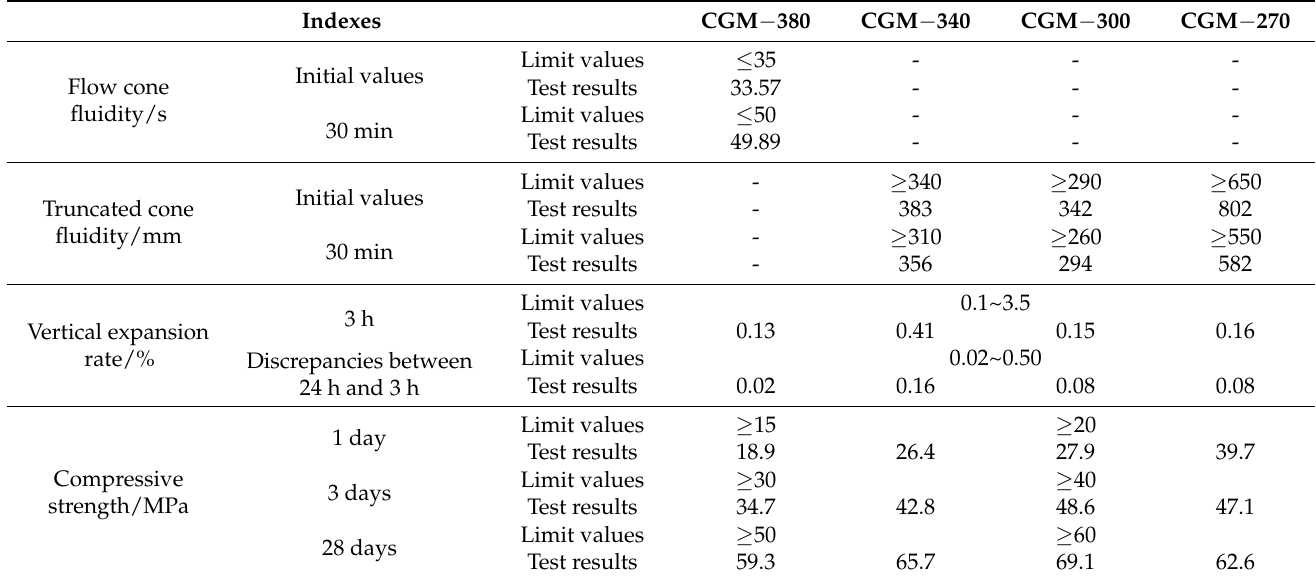
Table 1. Test results of fluidity, vertical expansion rate, and compressive strength of cementitious grouts.